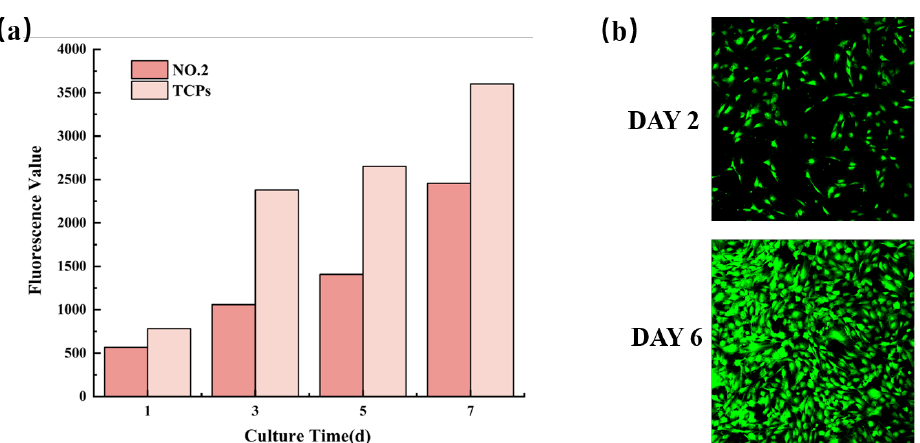
Figure 8. Characterization of MC3T3-E1 proliferation on